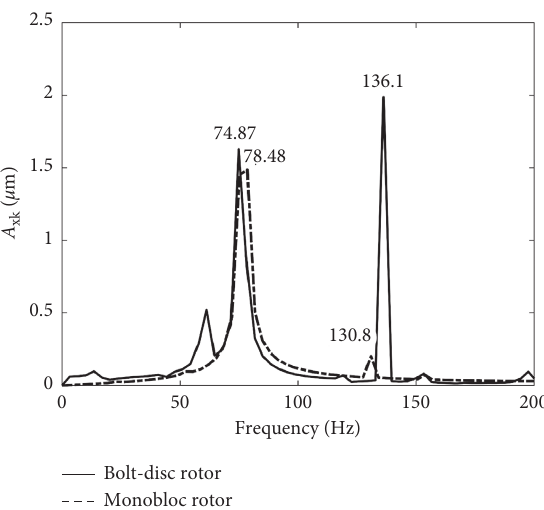
Figure 11: Frequency spectrums of both imprecise rotors with position error at the bearing